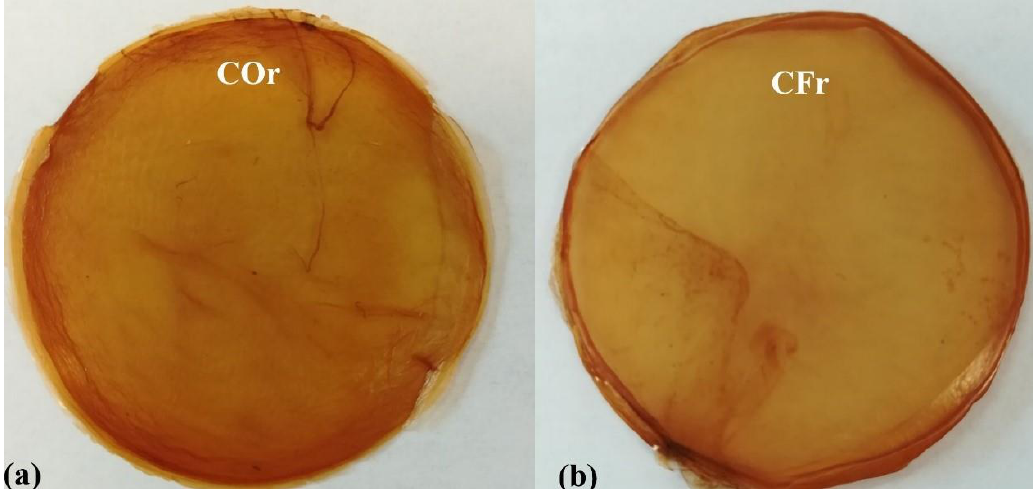
Figure 4. Representative images of the microbial cellulose films produced by the consortia ( a ) COr + Glucose and ( b ) CFr + Dextrose in a medium based on green tea after 15 days of fermentation at 25 °C.